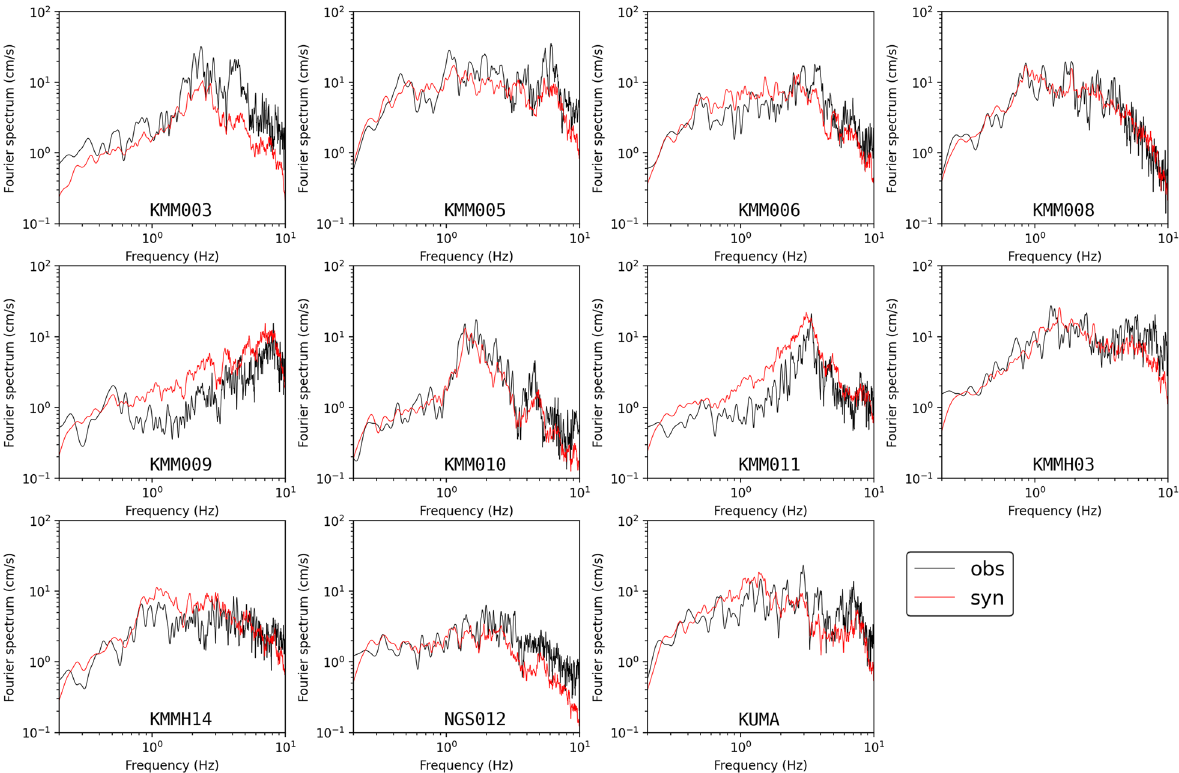
Fig. 5 Synthetic and observed Fourier spectra for the earthquake of 2016/04/16 3:03 ( M w 5.5). Black lines indicate the observed Fourier spectra. Red lines indicate the synthetic Fourier